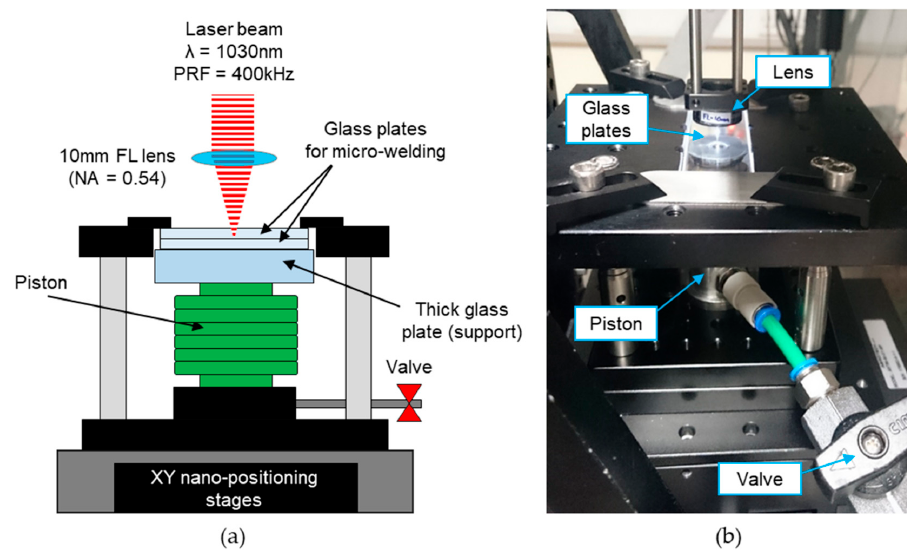
Figure 2. Holder used for the microwelding of two glass plates: ( a ) schematic, and ( b ) photograph.